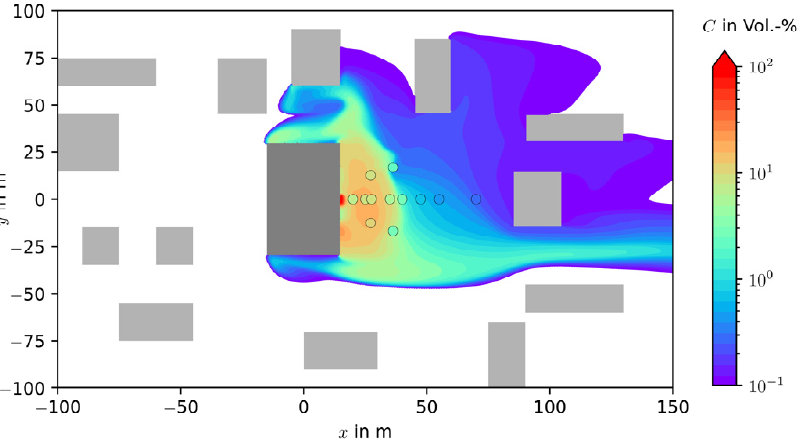
Figure 13. Heavy gas dispersion out of a vertical source with “channeling” of the gas cloud (Case HG-MR-M2-S1-HF), concentration–isosurface in 2 m height over ground. Grey boxes representing buildings and the experimental measuring points represented by circles.